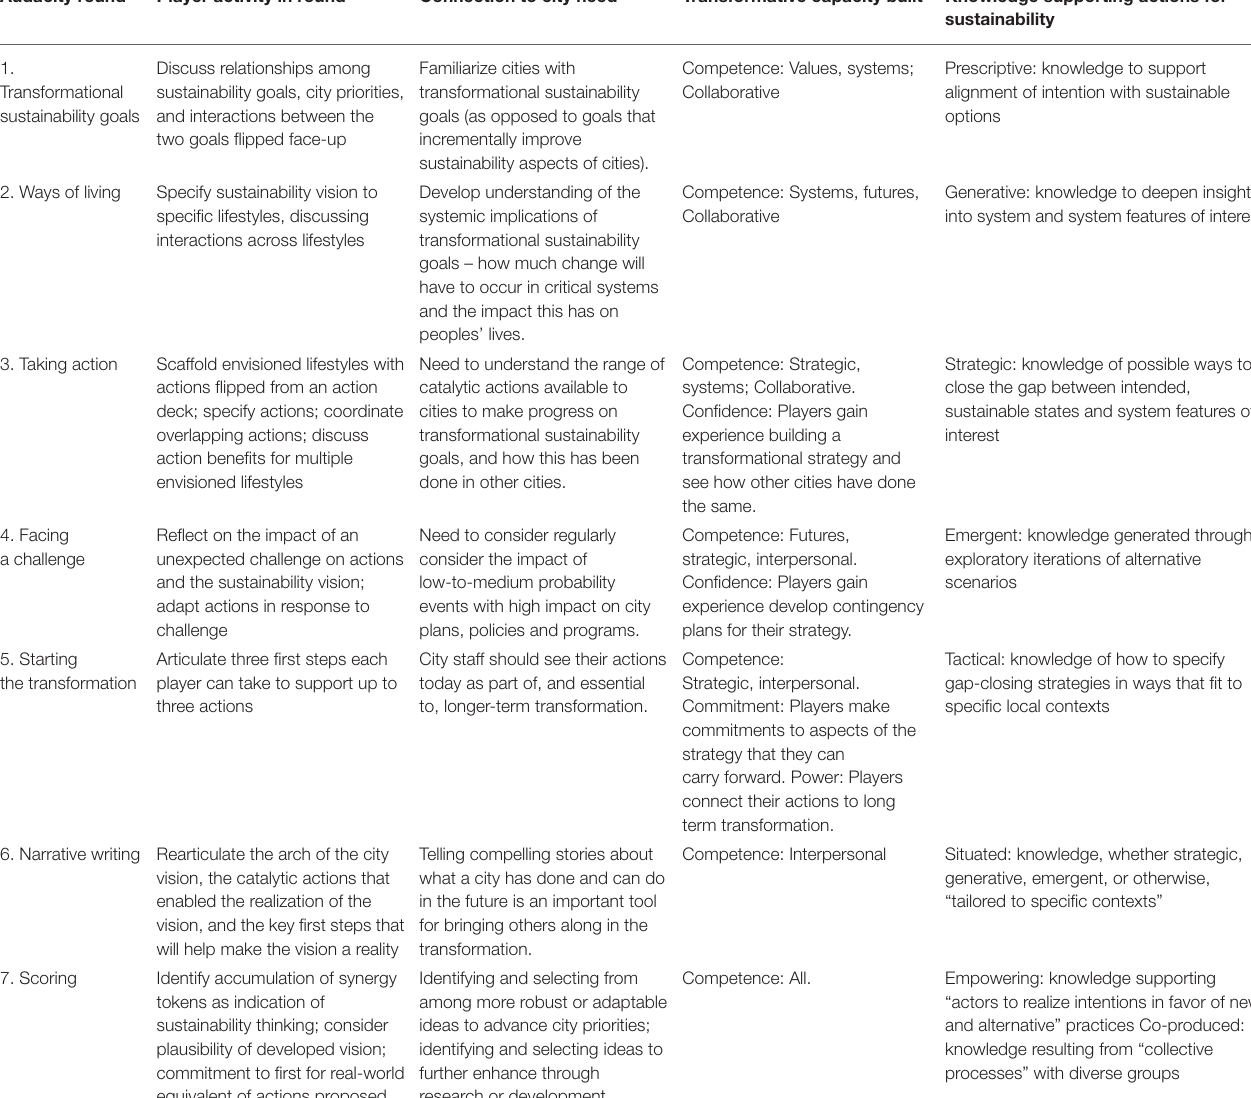
TABLE 3 | Overview of AudaCITY structure and desired learning outcomes for cities need, transformative capacity, and knowledge supporting actions for sustainability. Audacity